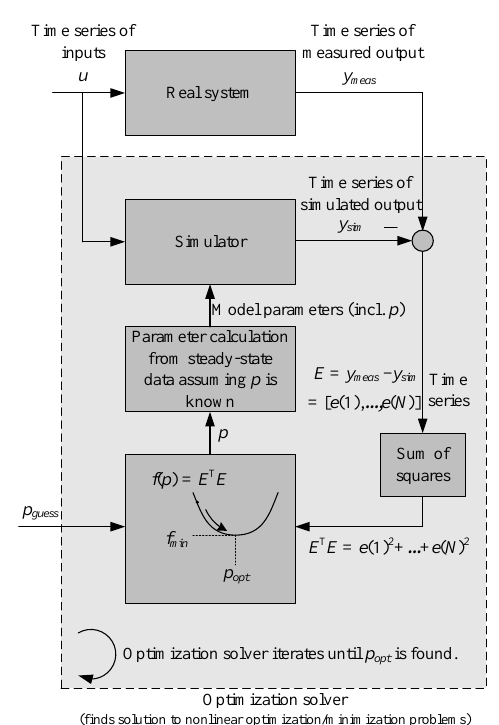
Figure 5: The estimation of parameter vector p = k 5 is based on optimization (minimization) using iterated simulations.